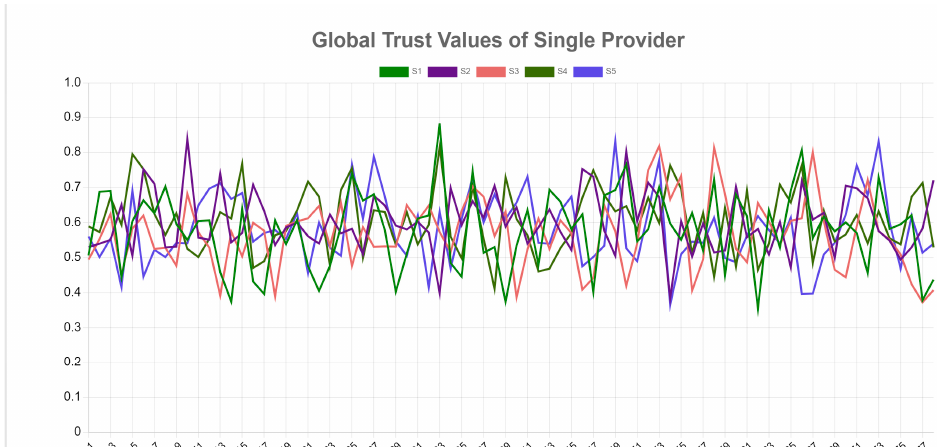
Figure 13. Global Trust Values (Tglobal) for 5 different services provided by SP2.